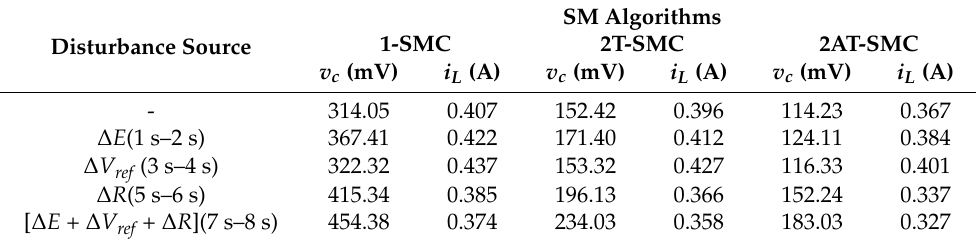
Table 6. Experimental comparisons of response